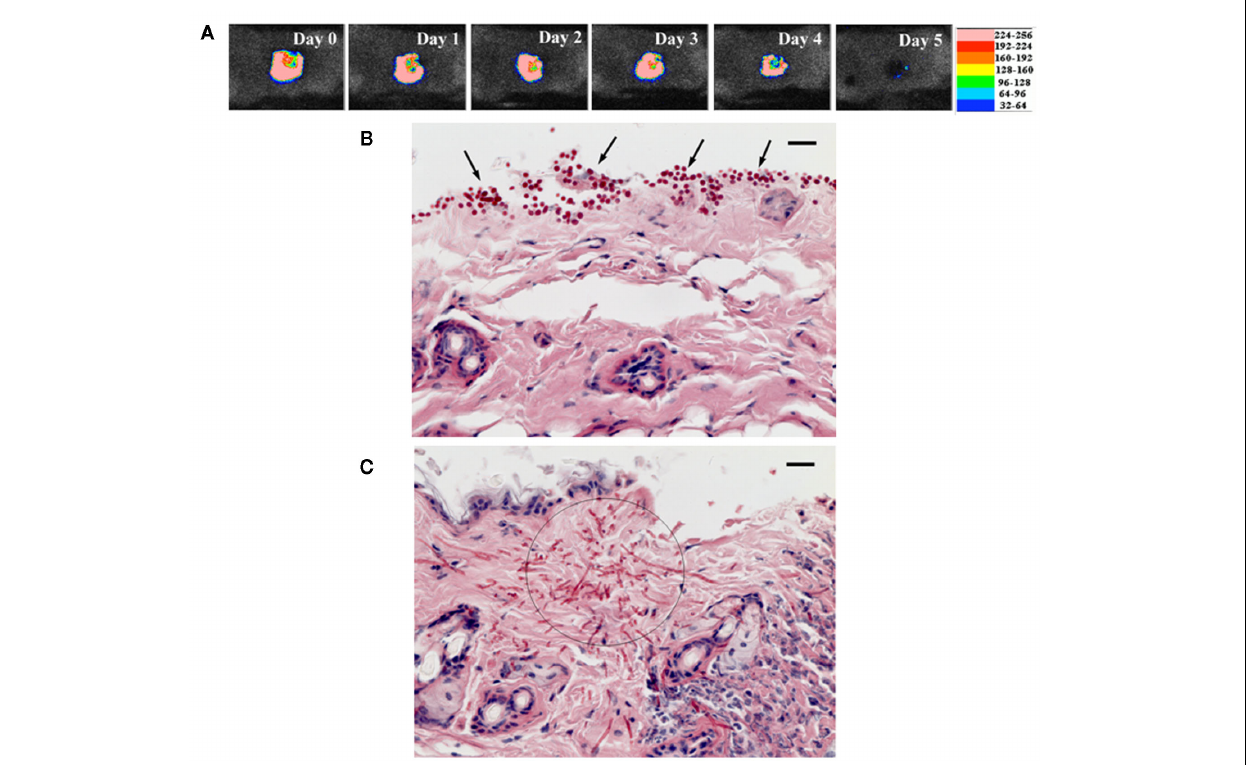
abrasion infected with 10 7 CFU C. albicans , showing the presence of yeasts [ (B) , arrows], hyphal filaments [ (C) , circle], and inflammatory infiltrate (C) . Biopsy was taken on day 1 postinfection. Bar, 20 μ